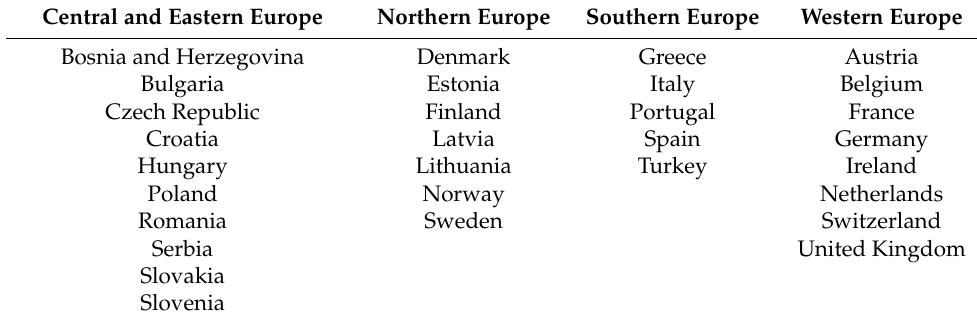
Table 1. Geographical subregions of Europe. Central and Eastern